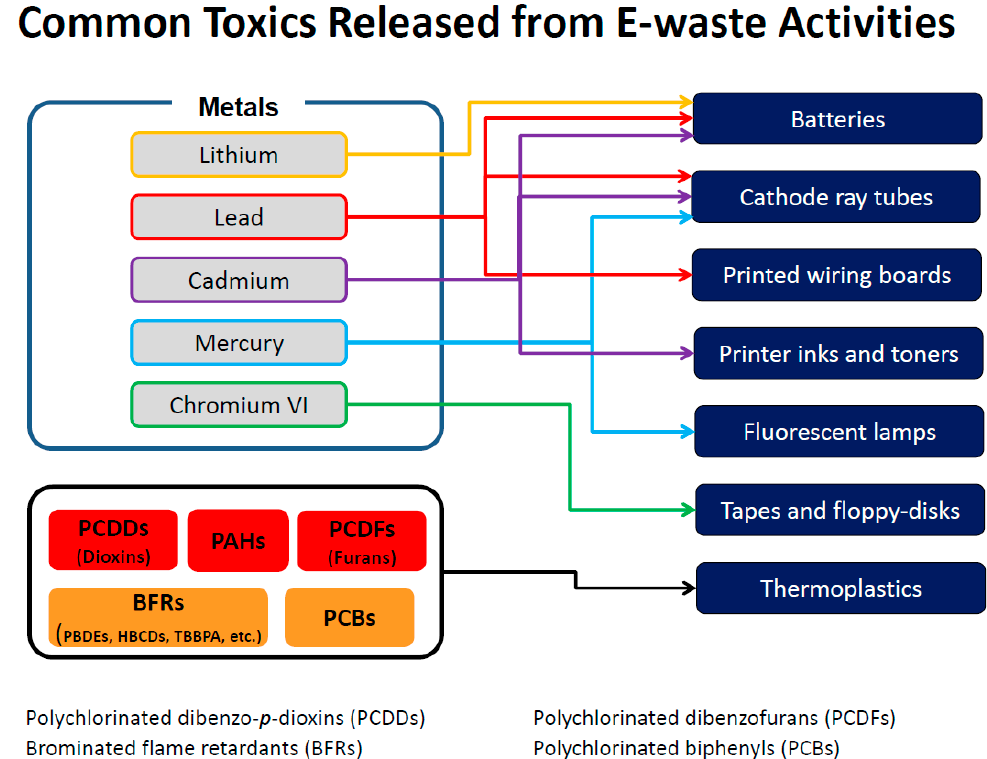
Figure 1. Sources and chemicals released from some specific e-waste sites. Adapted from: Frazzoli, et al. [30].